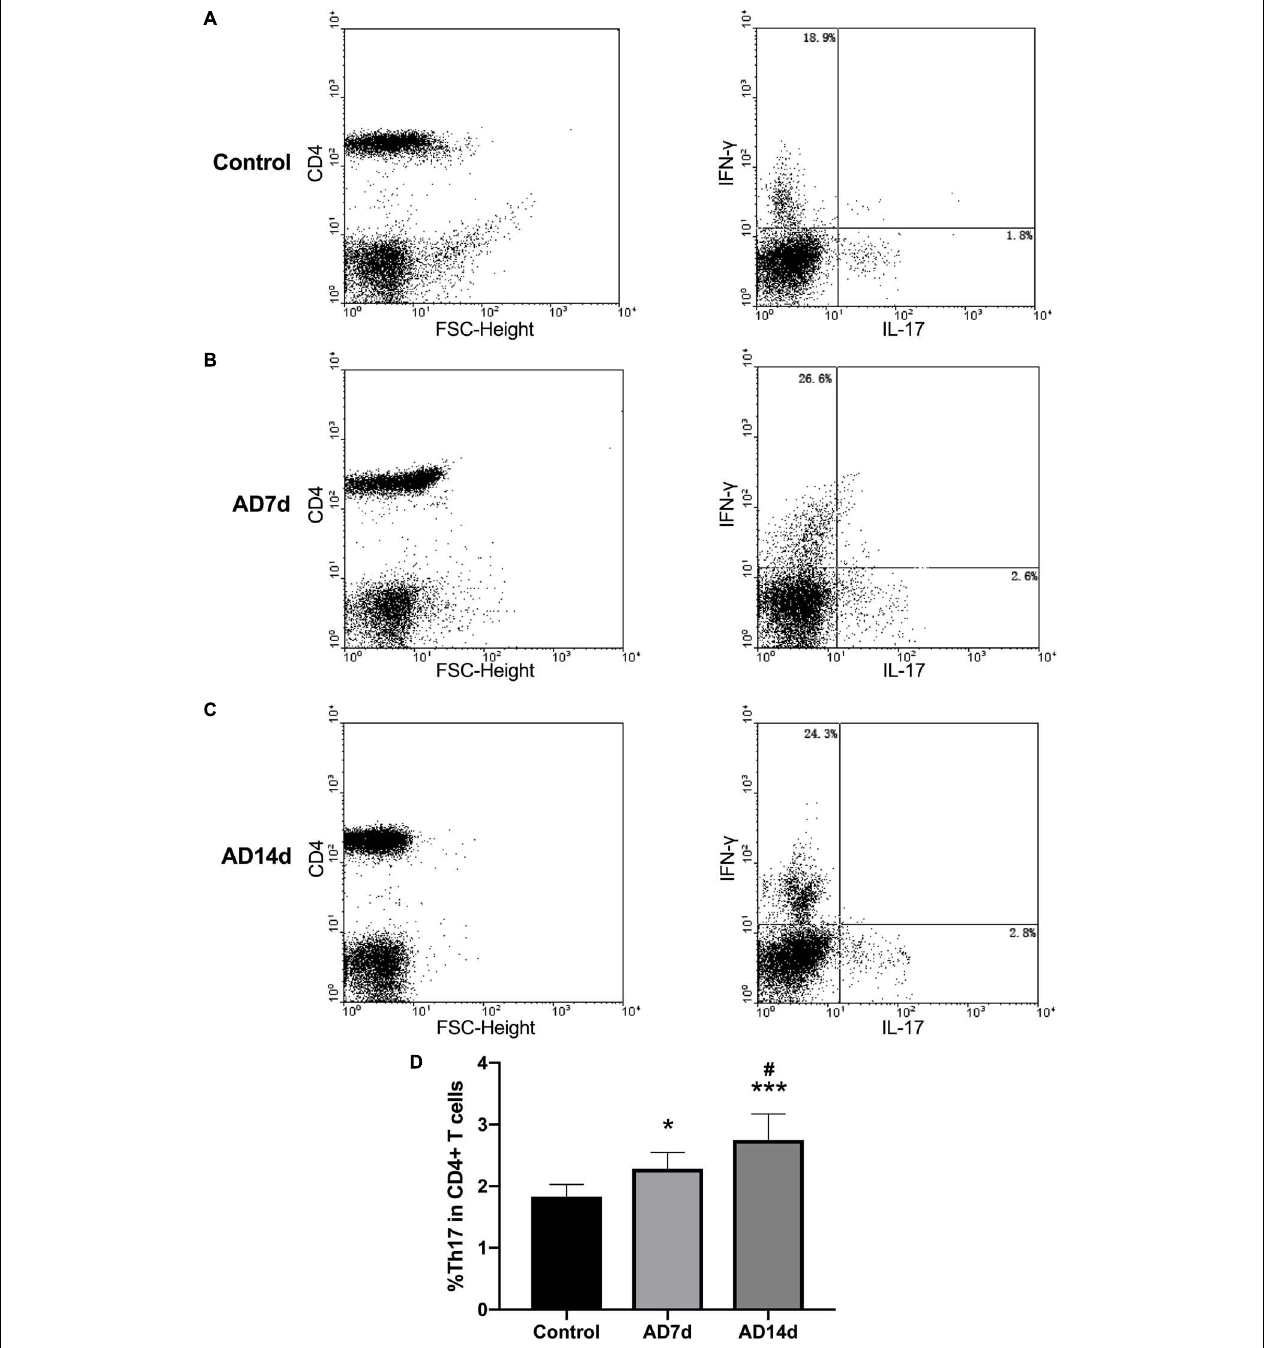
FIGURE 6 | Elevated circulating Th17 populations in AD rats. The population of Th17, a subset percent of total CD4+ T cells, was estimated with use of flow cytometry. Dot plots shown are representative of rats in the Control (A) , AD7d (B) , and AD14d (C) groups. Th17 cells were confirmed as CD4 + IL-17 + IFN- γ - cells. Numbers in each compartment indicate the proportions of Th17 and Th1 in CD4 + cells. (D) Percent of Th17 in total CD4+ T cells in the Control, AD7d and AD14d groups. n = 9 per group, mean ± standard deviation, ∗ P < 0.05, ∗∗∗ P < 0.001 vs. Control group, # P < 0.05 vs. AD7d